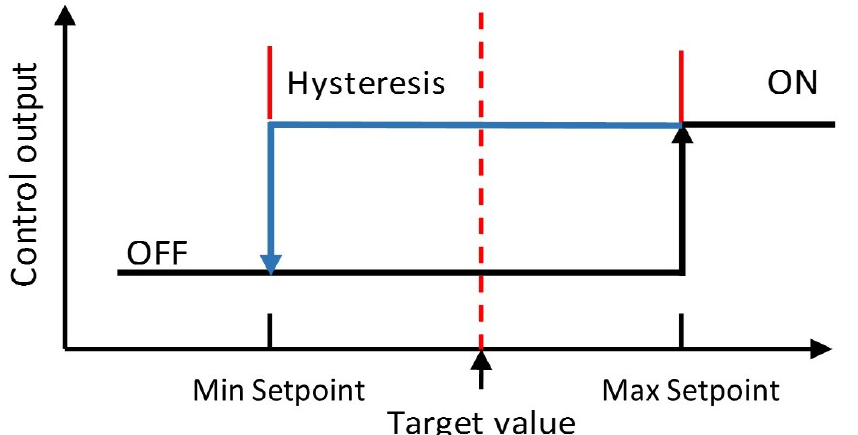
Figure 8. A schematic showing hysteresis between ON and OFF operations. The established platform automatically controls the inner greenhouse relative hu- midity by controlling the Fogger Fans (FFs) on/off. Once the inner greenhouse relative humidity became smaller than Min Setpoint ( 45% ) , the FFs will be turned on to raise the inner greenhouse relative humidity to be greater than or equal to the Max Setpoint ( 55% ) . Then, the FFs will be turned off. Therefore as shown in the figure, the inner green- house relative humidity is tightly scattered around the Min Setpoint and the Max Setpoint